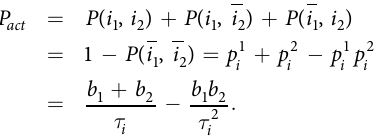
τ ) > 0, we need act (